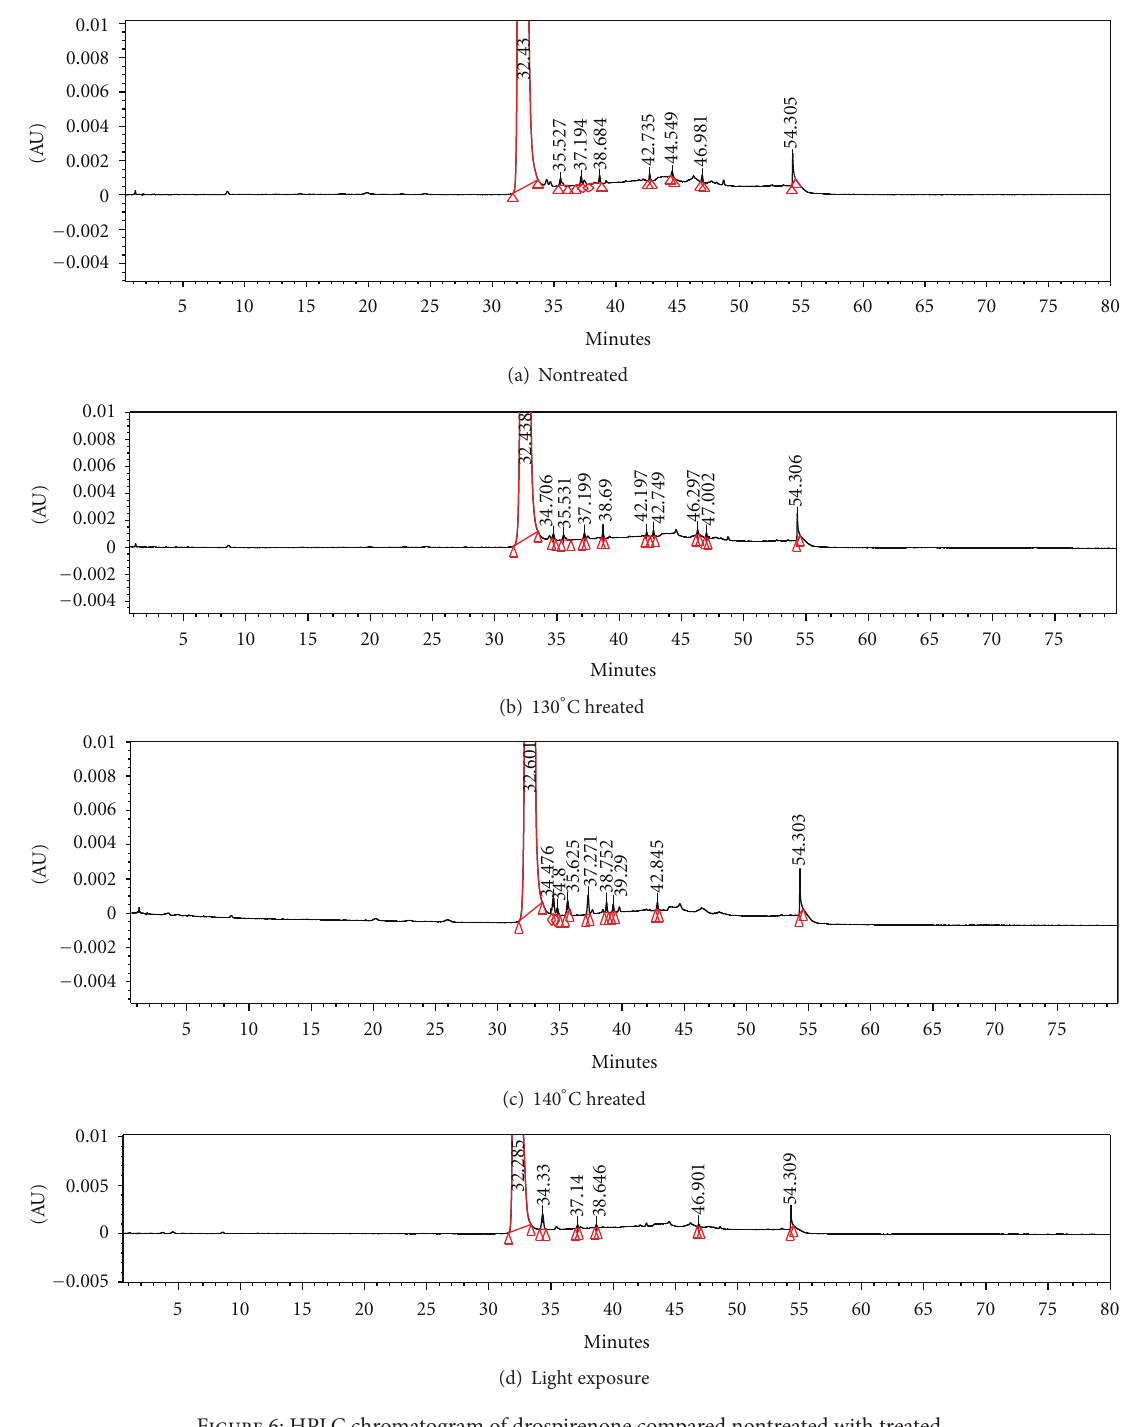
F 6: HPLC chromatogram of drospirenone compared nontreated with